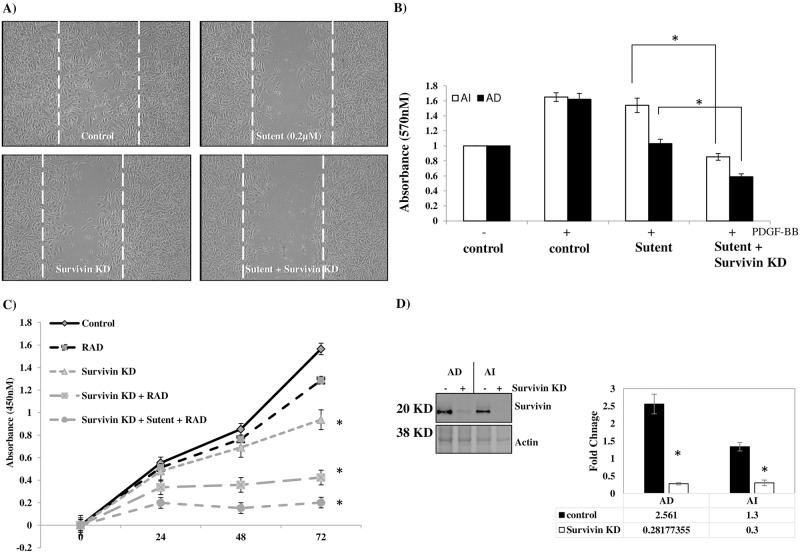
Sutent combined with survivin knock-down exhibits added effect on inhibition of cell migration and invasion and enhanced AI radio-sensitivity.(A) NB AD cells treated with 0.2 μM sutent plus survivin knock-down exhibited an added effect on the inhibition of cell migration as assessed with a ‘wound-healing’ assay compared to either treatment alone. (B) AI tumorspheres (white bars) treated with a combination of sutent (0.2 μM) and survivin knock-down exhibited a significant reduction in PDGF-BB (+) mediated cell invasion capacity compared to sutent treatment alone or untreated controls. AD cells (black bars) treated with sutent alone exhibited inhibition in PDGF-BB (+) mediated cell invasion, which was also enhanced in combination with survivin knock-down. (C) Survivin knock-down in AI tumorspheres increased radio-sensitivity when combined with sutent treatment by exhibiting an added effect on inhibition of cell proliferation after radio-therapy compared to survivin knock-down alone. (D) Western blot analysis confirms significant knock-down of survivin protein expression in neuro2a AD cells and AI tumorspheres measured after 48 h of siRNA transfection. * indicates a P value < 0.05. Results represent the mean ± SEM of multiple experiments.